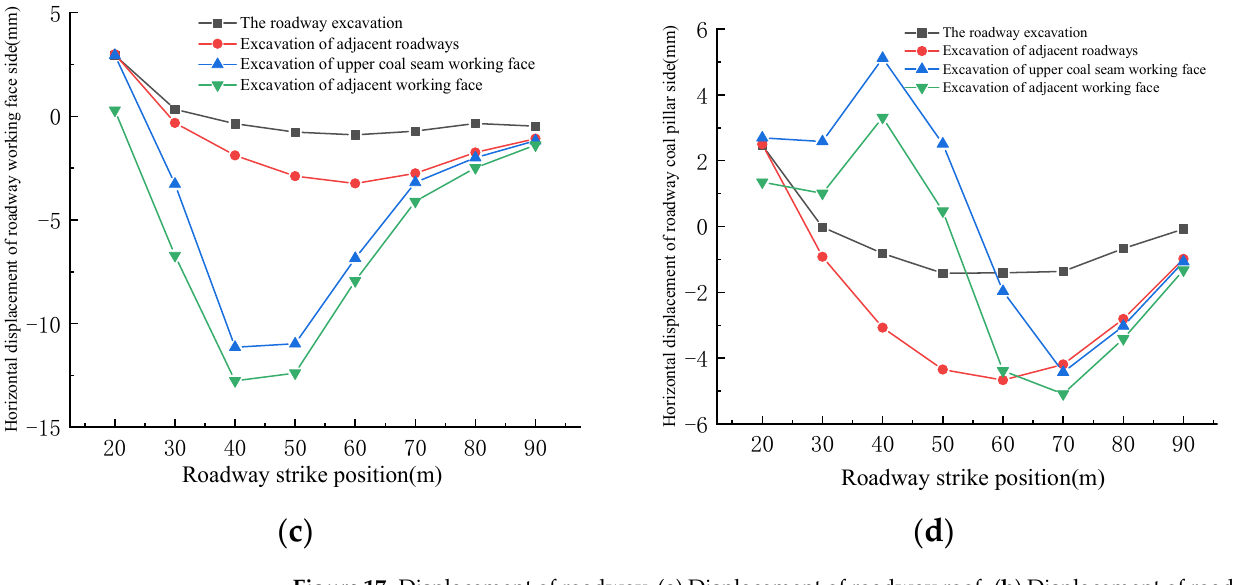
Figure 17. Displacement of roadway. ( a ) Displacement of roadway roof. ( b ) Displacement of roadway floor. ( c ) Displacement of roadway in working face side. ( d ) Displacement of roadway in coal pillar side.